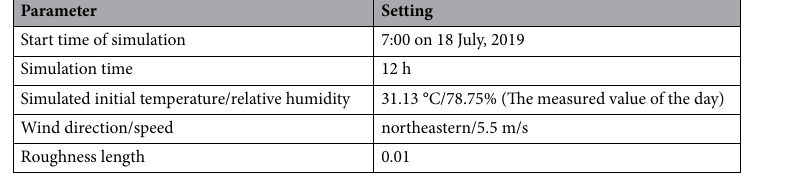
Table 2. Input parameter setting in simulations.